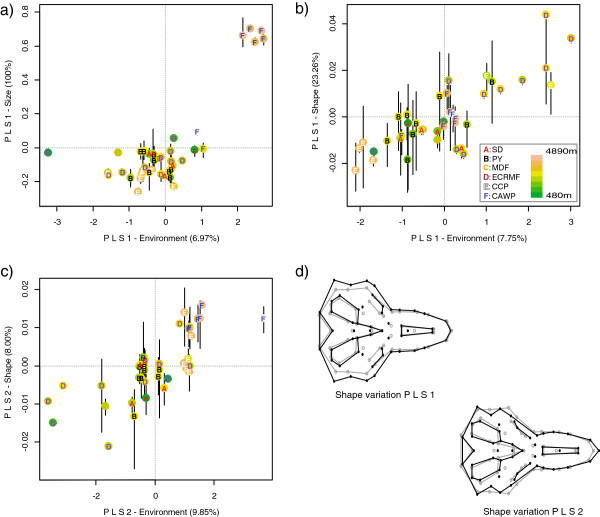
Morphological-environmental association recovered in the PLS analyses. Scatterplots of the single set of PLS axes for the analysis on size (a), and the first (b) and second (c) set of PLS axes for the analysis on uncorrected shape (results for the size-corrected shape data were similar; not shown). Although PLS analyses were run on population-averaged data, the extent of local intra-population variability is depicted as vertical lines below and above each population score, with the line lengths determined by the minimum and maximum individual scores obtained for each population when all individuals are projected onto each morphological PLS component. In (d) the morphological changes associated with the PLS axes shown in (b) and (c) are summarized by comparing the skull regions associated with each PLS (in black) with the overall mean shape of the entire sample (in grey). Scatterplot symbols follow Figure 2.